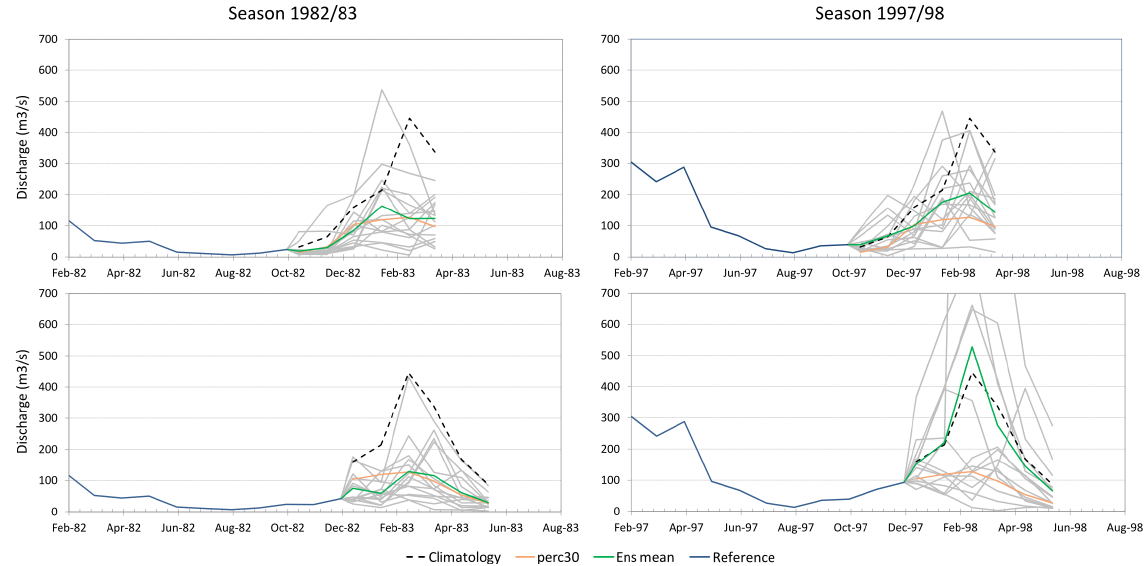
Figure 11. Seasonal forecast FS_S4 for 2 seasons issued in October (upper panel) and December (lower panel).